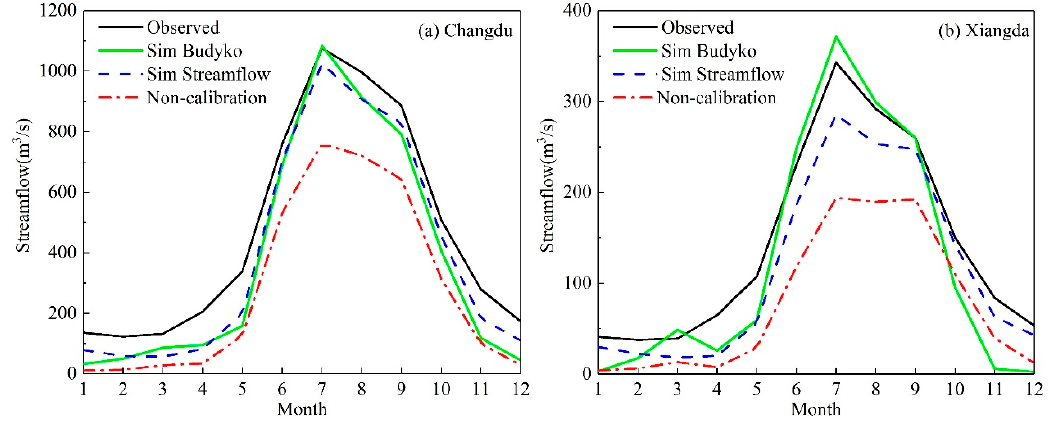
Figure 6. Average monthly streamflow hydrograph simulated with different calibration approaches (Sim Budyko, Sim streamflow, non-calibration) in the UL-MR. ( a ) Changdu hydrological station; ( b ) Xiangda hydrological station.